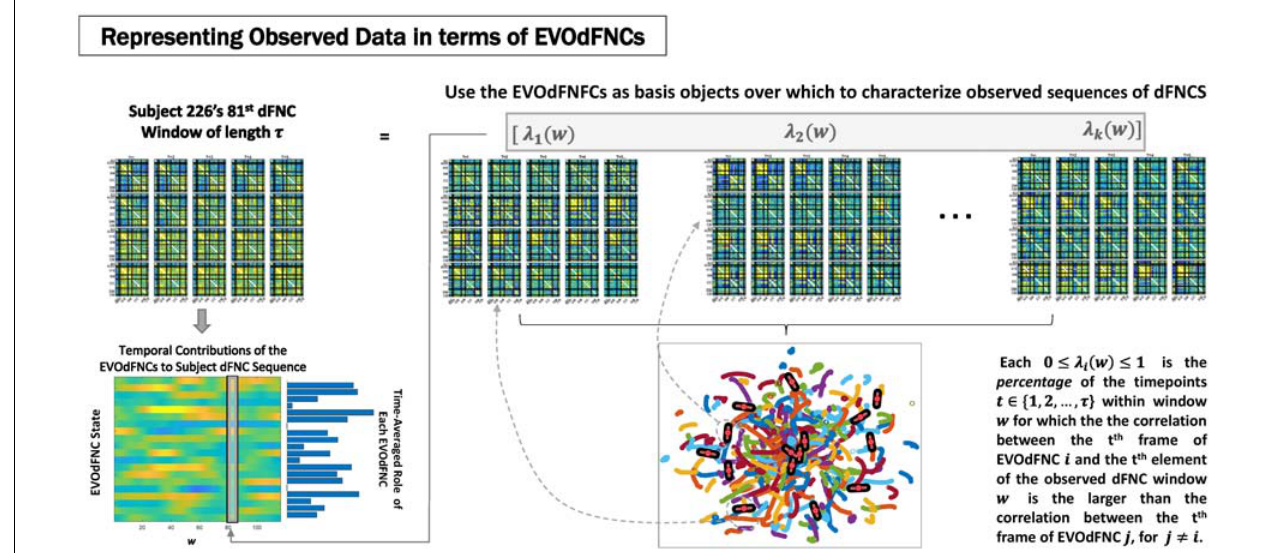
FIGURE 8 | Represent each length- τ window w from the observed subject dFNCs as a weighted combinations of the K EVOdFNC states (top row); Rather than simply regressing full 1081 τ = 47 , 564-dimensional dFNC windows on the K 1081 τ -dimensional EVOdFNCs, which ends up highlighting the relationship, we go time point–wise through the data window and EVOdFNCs, expressing each time point t of the data in terms of the corresponding time point in each EVOdFNC, then averaging this evolving correspondence over the window w between the observation and each EVOdFNC k to obtain the weight β k ( w ) for the k th EVOdFNC on the r th length- τ window of the subject’s dFNC sequence. This yields a K -variate time series expressing the subject’s observed sequence of dFNCs in terms of time-indexed weightings on the EVOdFNCs (bottom left).